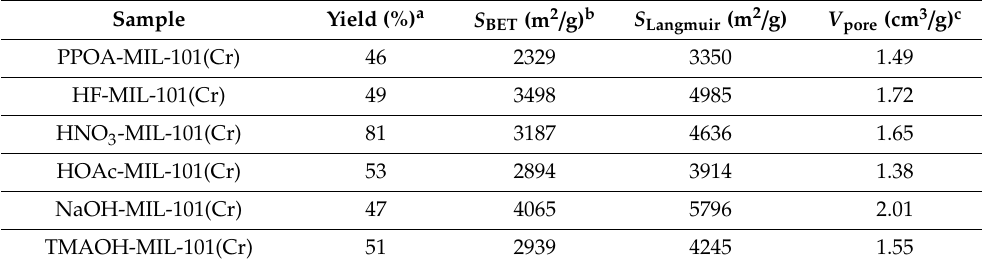
Figure 2. ( a ) Nitrogen adsorption-desorption isotherms of MIL-101(Cr)s, ( b ) and the corresponding pore size distribution curves (PSDs), which were calculated by the nonlocal-density functional theory (NL-DFT) model. Table 1. The yield, surface area and pore volume of MIL-101(Cr) products with distinct